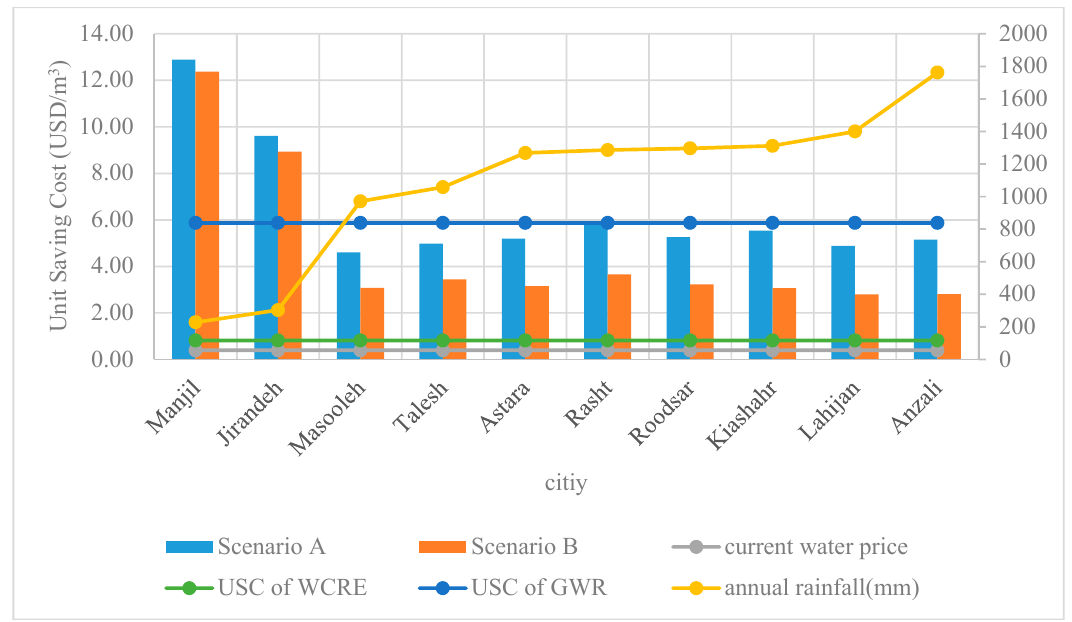
Figure 10. The unit saving cost of all stations using the optimal tank size.